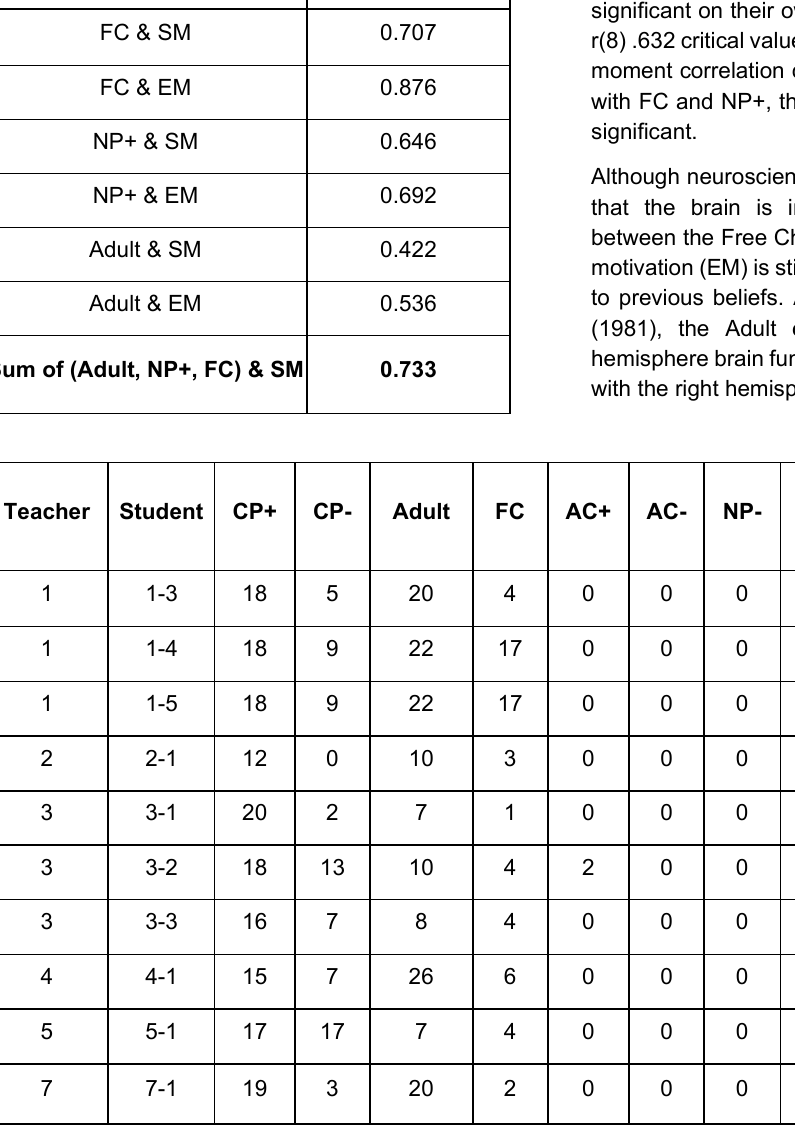
Table 1: Abundance, consisting of data from each egogram and each questionnaire.